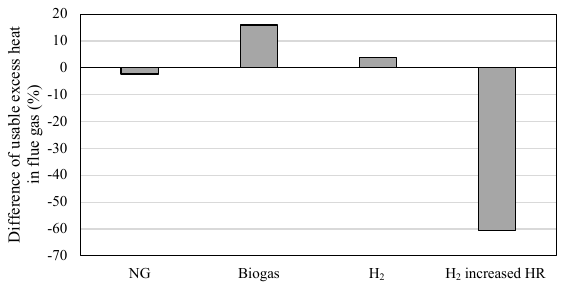
Figure 4. Available excess heat in HSM for various fuels relative to the base